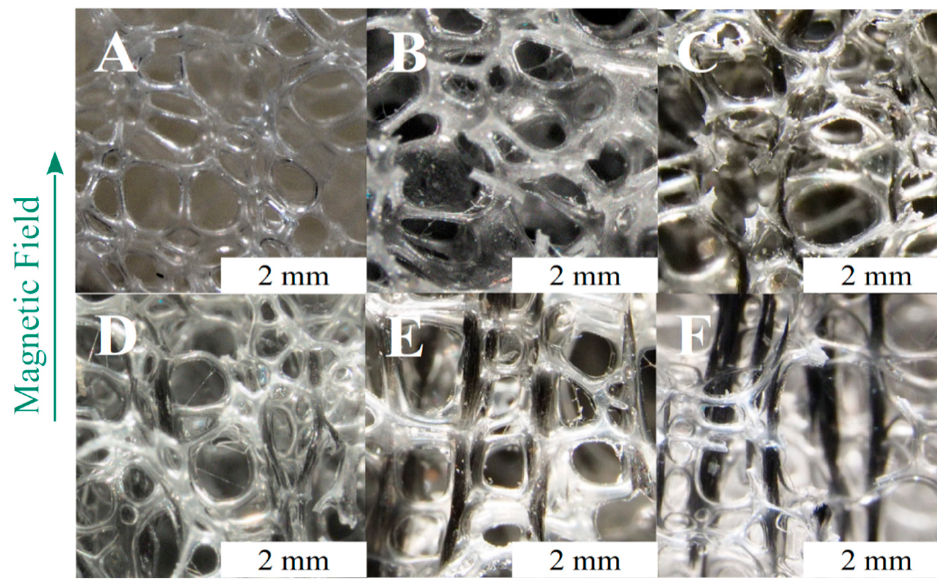
Figure 4. Optical micrographs of the following samples: ( A ) PU, ( B ) RF, ( C ) AF_24_T0-10, ( D ) AF_48_T0-10, ( E ) AF_96_T0-10, ( F ) AF_189_T0-10. The scale bar is the same for all samples.